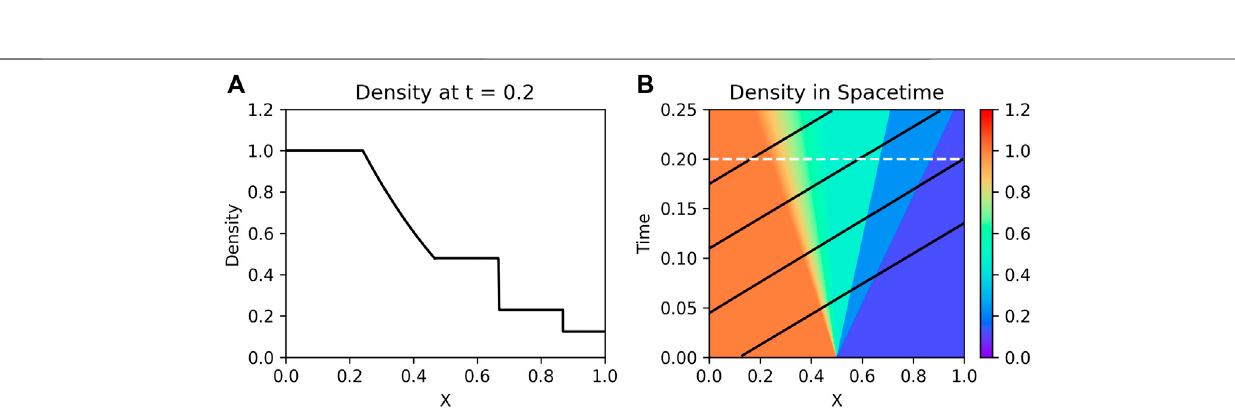
FIGURE2|(A) :SnapshotofSodshocktubedensityat t (cid:1) 0.2. (B) :Fullspace-timepictureofdensity;whitelineindicates t (cid:1) 0.2;blacklinesrepresenttrajectoriesof data sampling for neural network boundary fi ts.